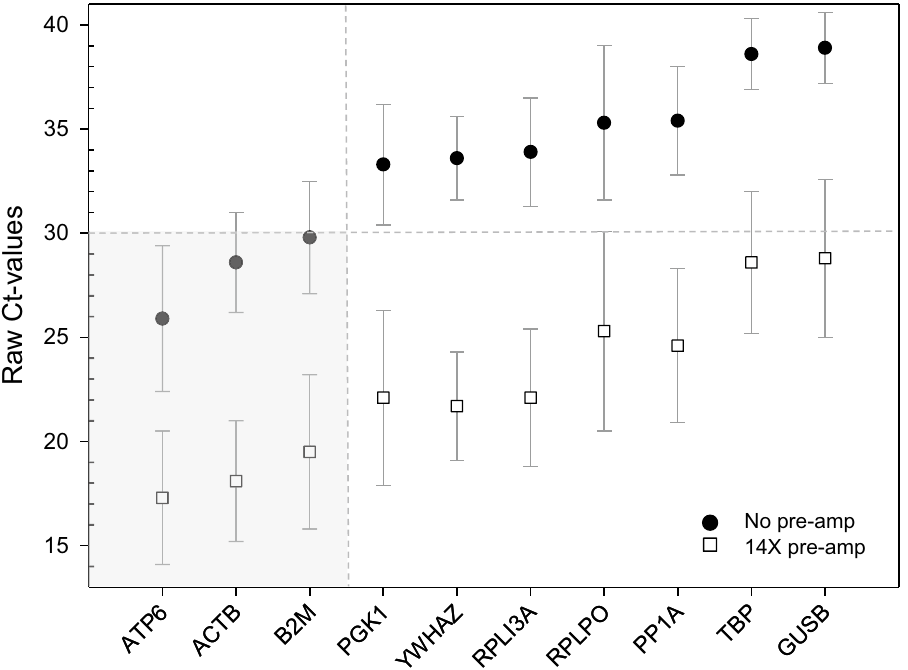
Figure 5. The graph represents raw Ct values (threshold cycles) of potential housekeeping genes (n = 10) analyzed for the 40 samples from 10 donors (four time points per donor), arranged in ascending order of raw unamplified Ct values. For each gene, the Ct values measured via qRT-PCR with cDNA without pre- amplification as well as after 14× pre-amplification is shown. Symbols represent geometric mean values and error bars reflect the standard error of mean per gene. Vertical and horizontal grey dashed lines show the cut-off (mean Ct ≤ 30). Three of the genes ( ACTB , ATP6 and B2M , highlighted in grey area) showed un-amplified Ct-values < 30 indicating that no pre-amplification for adequate detection will be